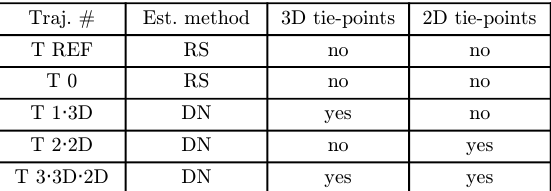
Table 1. Overview of the examined trajectories and their char- acteristics, i.e., the estimator used to compute them and the in- clusion of tie-points with the IMU and GNSS observations. RS: recursive smoother, DN: dynamic network.